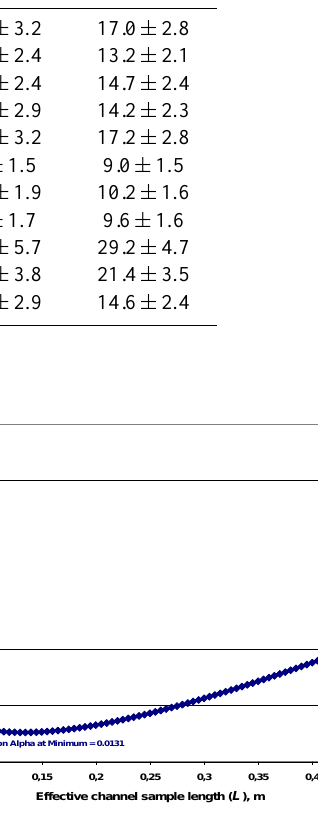
Fig. 11. Sum of squared deviations from lines of best fit as a func- tion of Matheron’s α and linear sample length L . The rapid in- crease of this function near L = 0 probably reflects randomness at the microscopic scale plus white noise due to measurement errors. Optimum effective channel sample width ( L = 0.13m) is based on variogram values with limited precision for the 2 to 20m neigh- bourhood. Because of this, this estimate is subject to uncertainty. It could reflect the fact that the Tajo vein was formed by crystallization of ore minerals outward from a narrow fissure in the surrounding sandstone and conglomerates (cf. Fig.